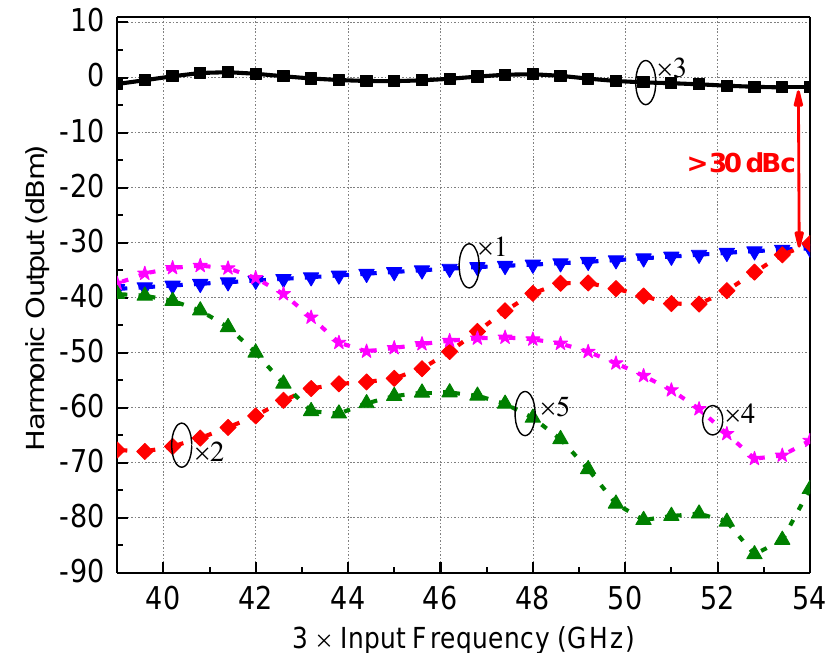
Figure 3. Simulated output power of the tripler with BPF.